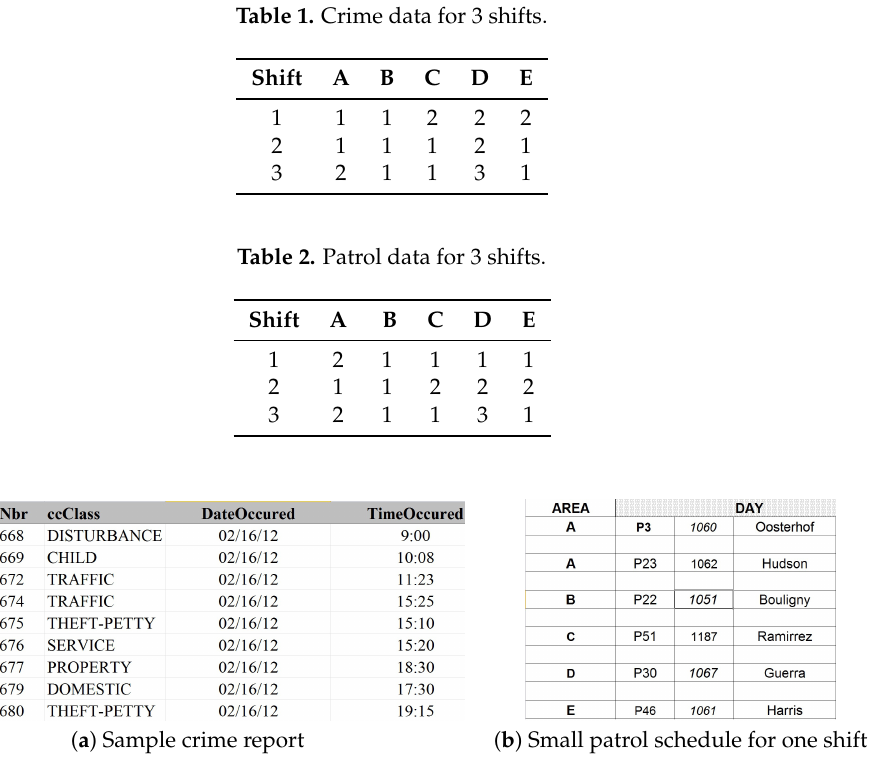
Figure 2. Sample data for (a) crime and (b) patrol